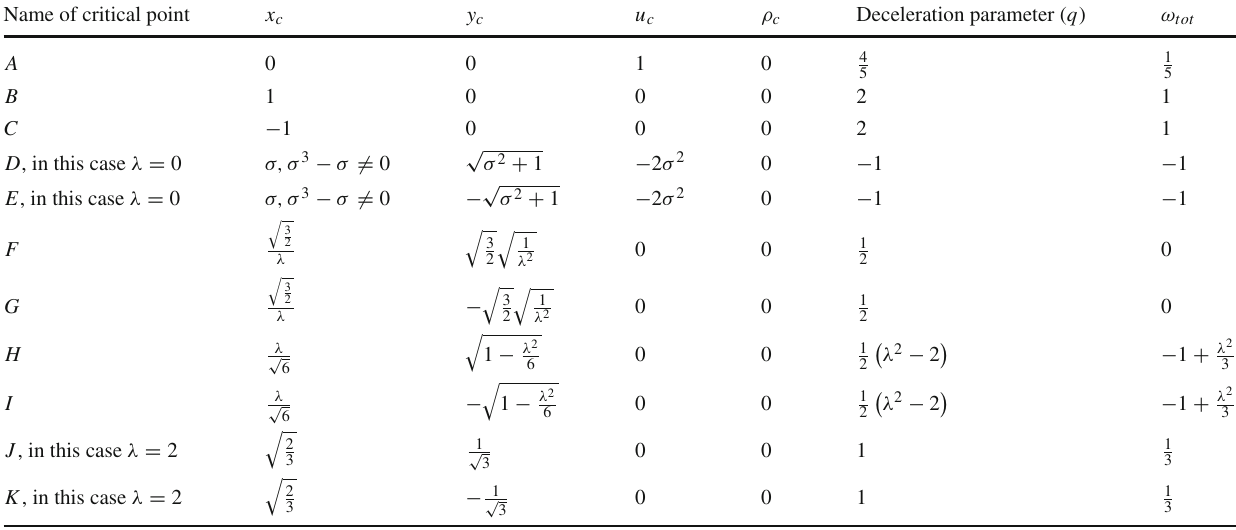
Table 9 Critical points for the dynamical system corresponding to updated calculations for Model-I Name of critical point